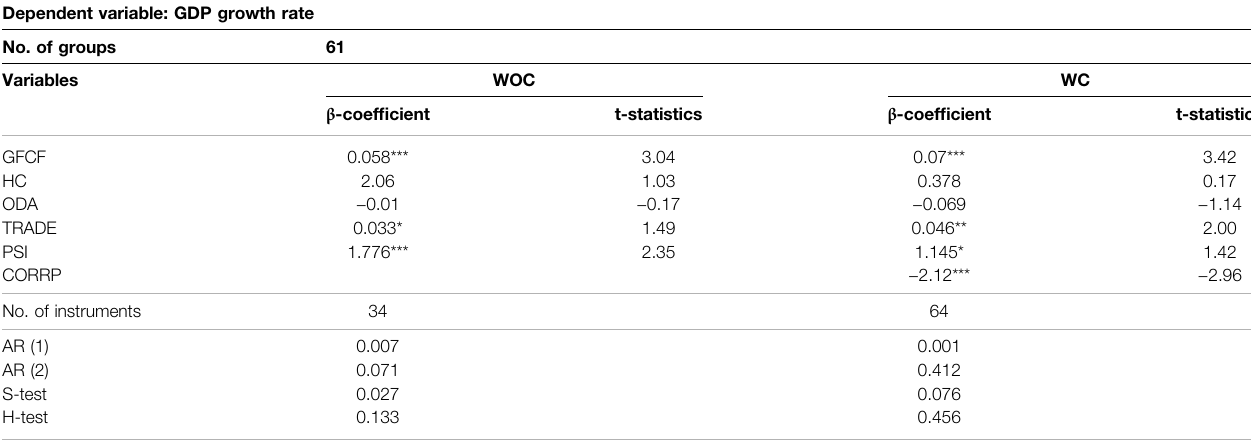
TABLE 7 | Results of difference GMM for all developing